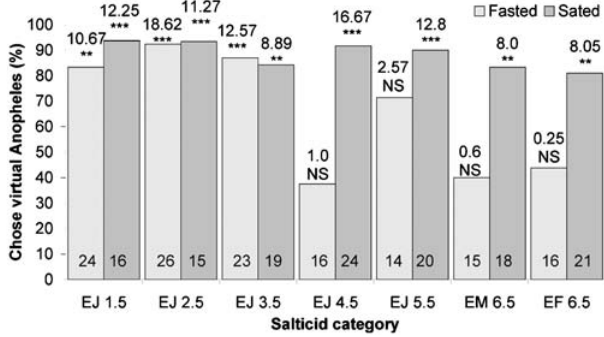
Figure 4. Simultaneous-presentation virtual-prey tests (blood-fed virtual mosquitoes in Anopheles rest posture and in Culex rest posture) of fasted and sated Evarchaculicivora. E= Evarcha culicivora . J=juvenile. F=adult female. M=male. Spider body length in mm. N inside each bar. Tests of goodness of fit: chi-square statistic above bar; null hypothesis, 50/50; *** P , 0.001, ** P ,